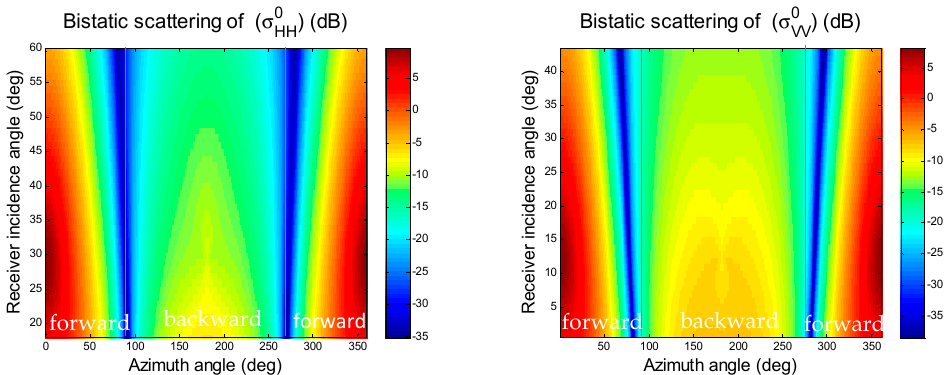
Figure 13. Bistatic scattering coefficients σ 0 and σ 0 when θ T = 29.55 ◦ , β = 0 ◦ , l = λ , s = λ /10 HH VV with exponential ACF.